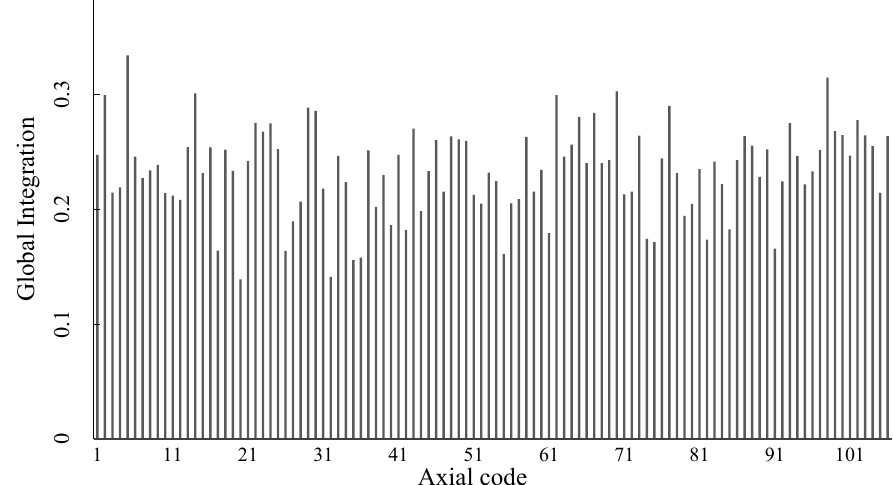
Figure 10. Integration value of each axial based on the space syntax.